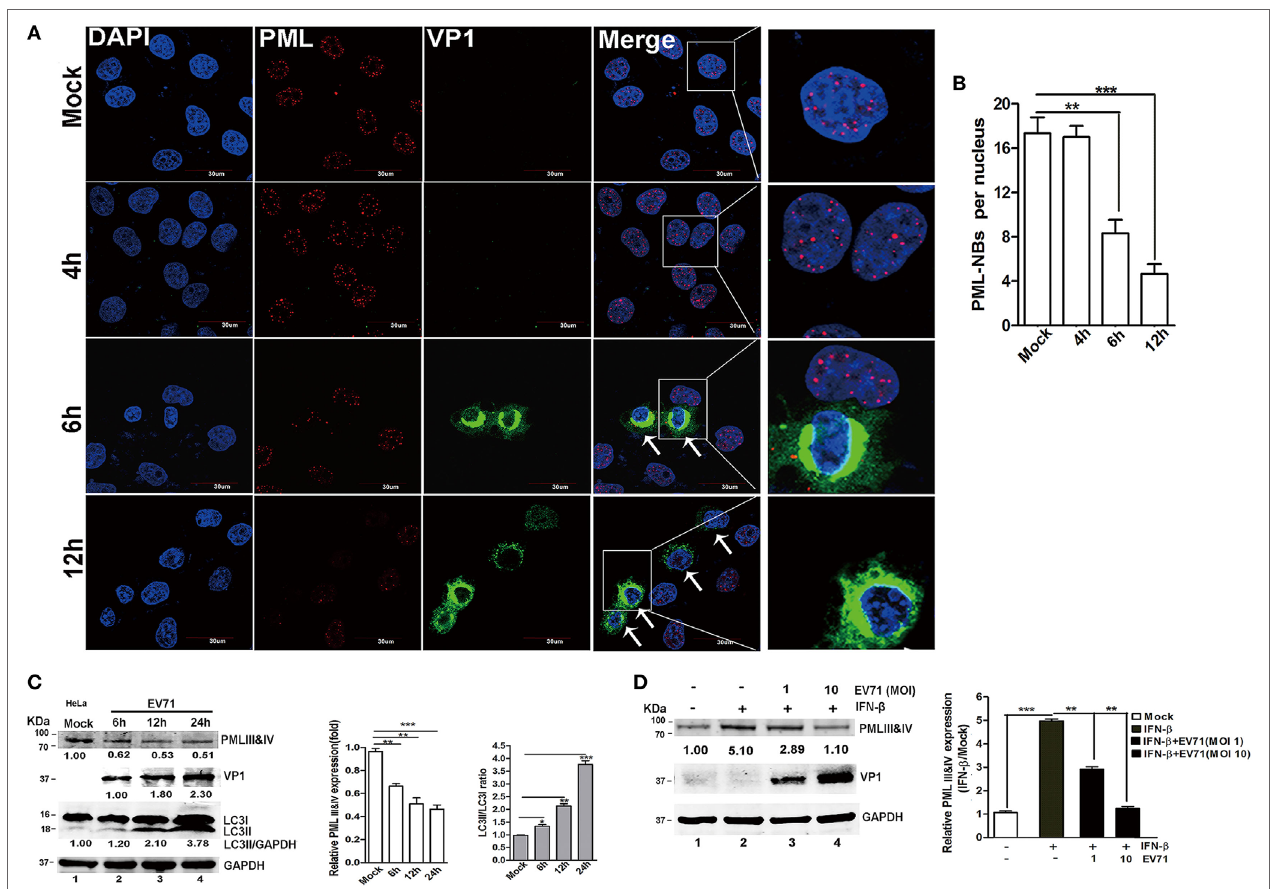
FigUre 6 | Enterovirus 71 (EV71) infection downregulated promyelocytic leukemia protein-nuclear bodies (PML-NBs) and resulted in a reduction in the promyelocytic leukemia (PML) protein level. (a) Alterations in PML-NBs in EV71-infected HeLa cells. HeLa cells grown on 12-well slides were mock-infected (upper panel) or infected with EV71 [multiplicity of infection (MOI) = 5]. At the indicated time points, the cells were fixed and stained with polyclonal antibodies against PML (red) and VP1 (green), and DAPI is shown in blue; the images were acquired under a confocal microscope. White arrows indicate the EV71-infected HeLa cells (PML-NBs were absent from the nuclei) (scale bar: 30 µm). The images are representative of three independent experiments. (B) A minimum of 50 cells was counted for the number of PML-NBs, and the mean number of PML-NBs per nucleus in the uninfected and infected cells in each group is presented. The presented values are the mean ± SEM (** p < 0.01, *** p < 0.001). (c,D) EV71 infection led to a decrease in the endogenous PMLIII and IV isoforms in cells treated with or without interferon (IFN)- β . (c) EV71 infection led to a decrease in endogenous PMLIII and IV isoforms at a later stage in the HeLa cells. Cells were mock- infected or infected with EV71 at an MOI of 5, and the cell lysates were analyzed at 6, 12, or 24 h post-infection (p.i.) by performing a Western blot analysis using antibodies against PML, LC3, VP1, or GAPDH. The relative expression of PMLIII and IV represents the density of the band compared with that of the corresponding control normalized to GAPDH. The value of the PMLIII and IV isoforms in the mock-infected cells (Lane 1) is set as 1.00 (100%). The ratio of LC3-II/LC3-I represents the relative density of the bands compared with that of the corresponding control normalized to GAPDH. The value of LC3-II/LC3-I in the HeLa cells that received the mock treatment is set as 1.00 (100%). Three independent experiments were performed, and representative data are shown. (D) EV71 infection reduced PMLIII and IV expression in IFN- β -treated HeLa cells. HeLa cells were treated with or without IFN- β (1,000 U/ml) for 24 h and then washed with fresh medium before being infected with EV71 at an MOI of 1 or 10. The cell lysates were analyzed by performing a Western blot analysis at 24 h p.i. using antibodies against PML, VP1, or GAPDH. The relative expression of PMLIII and IV represents the density of the band compared with that of the corresponding control normalized to GAPDH. The density value of PMLIII and IV in the mock-infected cells (Lane 1) is set as 1.00 (100%). All experiments were performed three times, and representative results are